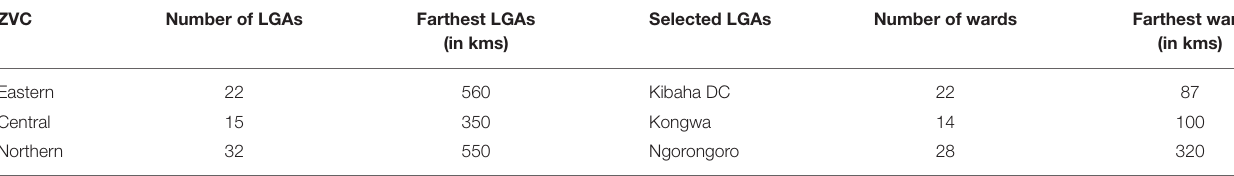
TABLE 4 | Area covered and furthest distance traveled by the DVOs and ZVC officers.